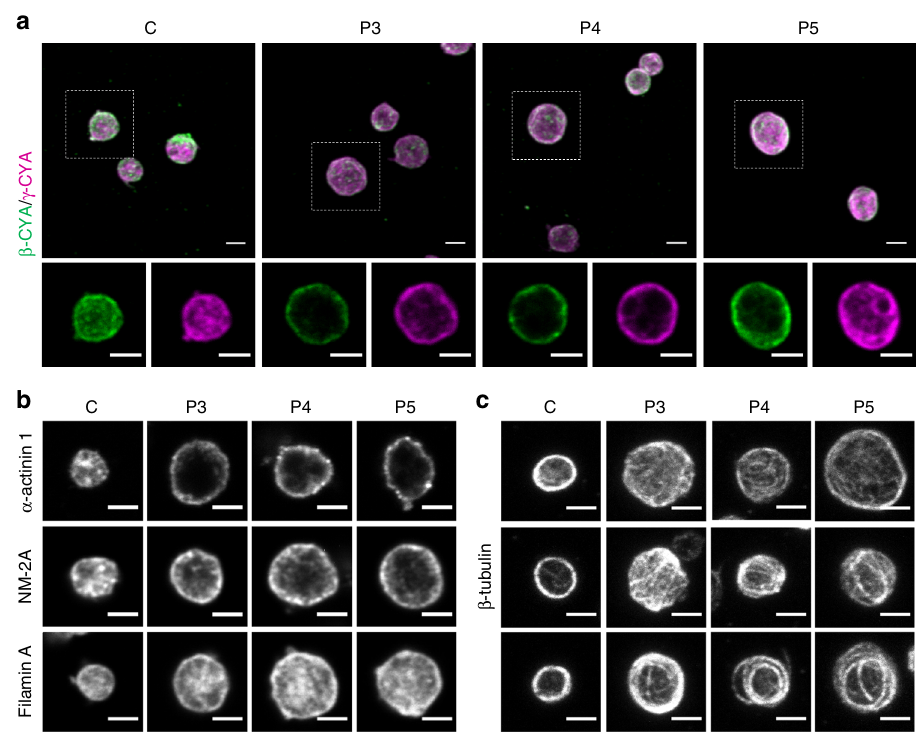
Fig. 7 ACTB -AST patient platelets have disordered actin and microtubule cytoskeletons. a – c Assessment of the actin and microtubule cytoskeletons in platelets puri fi ed from healthy control (C), patient 3 (P3), patient 4 (P4), and patient 5 (P5) EDTA-peripheral blood (1 experimental replicate); a Representative maximum intensity projections (top row) are given for β -CYA (green) and γ -CYA (magenta) labeled samples, showing reduced β -CYA: γ - CYA ratios in patient samples. Mid-stack slices of the marked regions of interest (white squares) are shown below, demonstrating cortical redistribution of actin isoforms in patient thrombocytes; b Mid-stack slices show strong cortical recruitment of NM-2A and α -actinin 1, and a moderate cortical enrichment of Filamin A in patient platelets; c Representative images demonstrate the highly disordered nature of β -tubulin in patient-derived platelets compared to those from a healthy control. 3 – 6 images (total of 20 – 60 platelets) were assessed for each protein of interest. All scale bars represent 2 µ